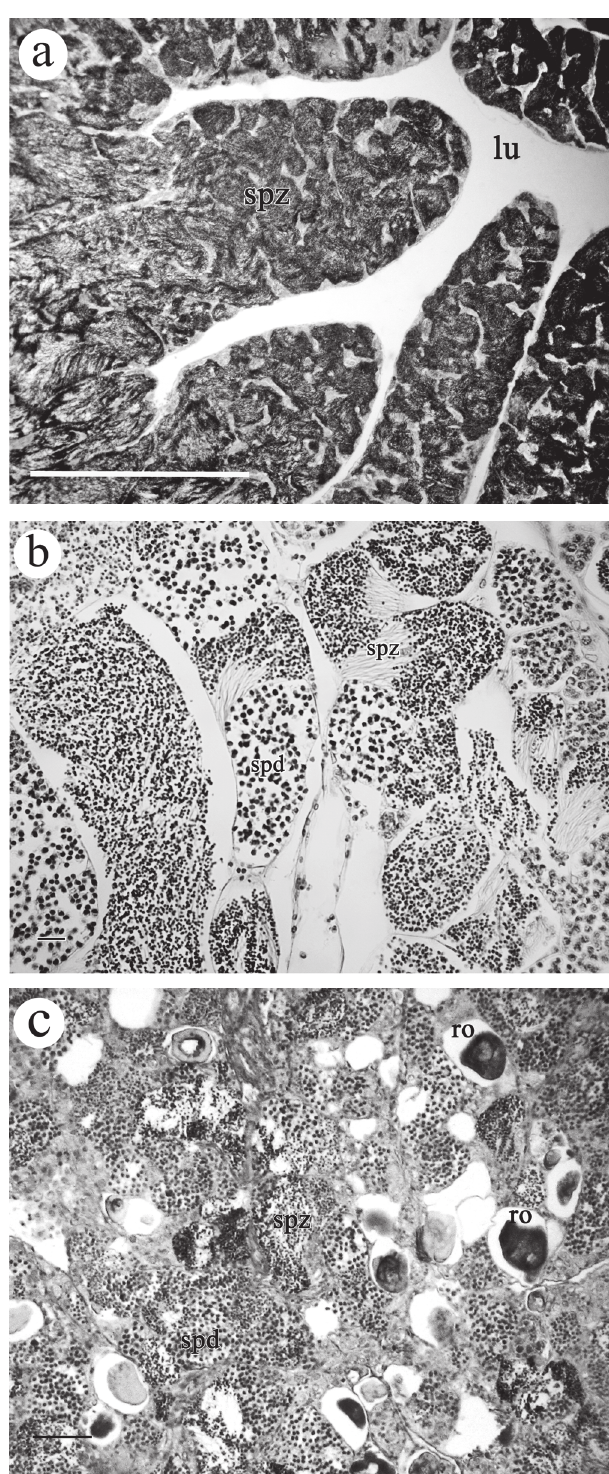
Fig. 2. Photomicrographs of histological sections from males Alphestes afer gonads. (a) , (b) Section from a ripe male (a - bar = 300 μ m, 15.1 cm T ; September 2008; b - bar = 37 μ m, 19.0 cm L T ; August 2009). (c) Section from a ripening male with residual L previtellogenic oocytes (bar = 50 μ m; 21 cm T ; June 2009). lu L = lumen, spz = spermatozoa; ro = residual oocytes.